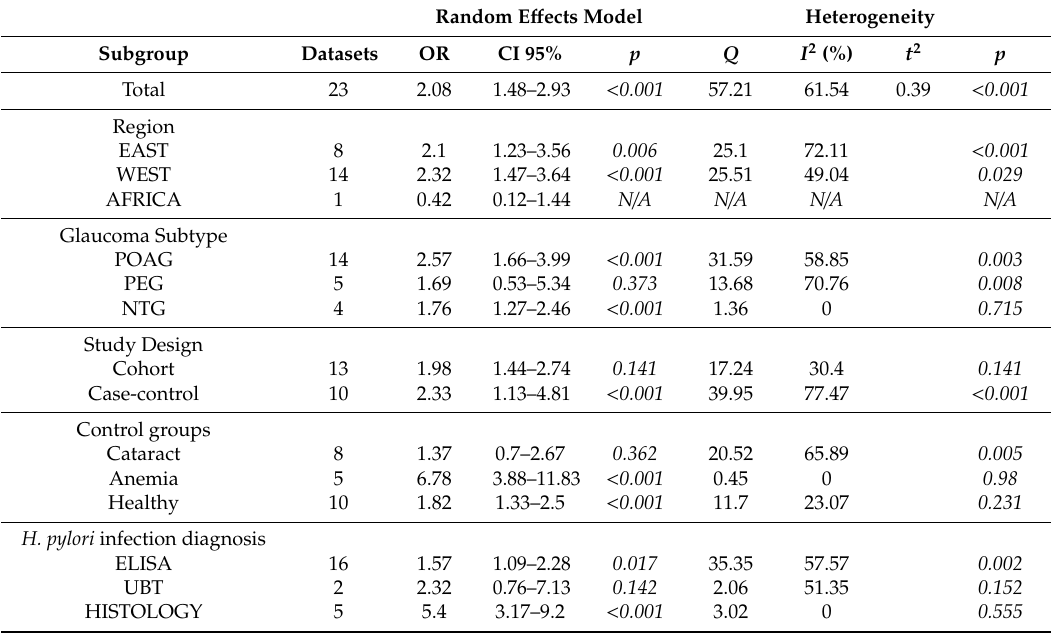
Figure 2. ( a ) Forest plot illustrating, in OR, the overall and per included study association between H. pylori infection and glaucoma risk. ( b ) Forest plot for the association between means of di ff erence of anti- H. pylori antibodies titers and glaucoma occurrence. ( c ) Meta-regression scatter plot indicating the relationship between the means of di ff erence of anti- H. pylori antibodies titers and glaucoma risk after adjustment for mean age. ( d ) Sensitivity analysis excluding our group’s studies and confirming the absence of bias because of our own studies. CI, confidence interval; H. pylori ; Helicobacter pylori ; NTG, normal tension glaucoma; OR, odds ratio; POAG, primary open angle glaucoma; PEG, pseudo-exfoliation glaucoma; MD, weighted mean di ff erences. Table 2. Subgroup analysis regarding the relationship between H. pylori infection and